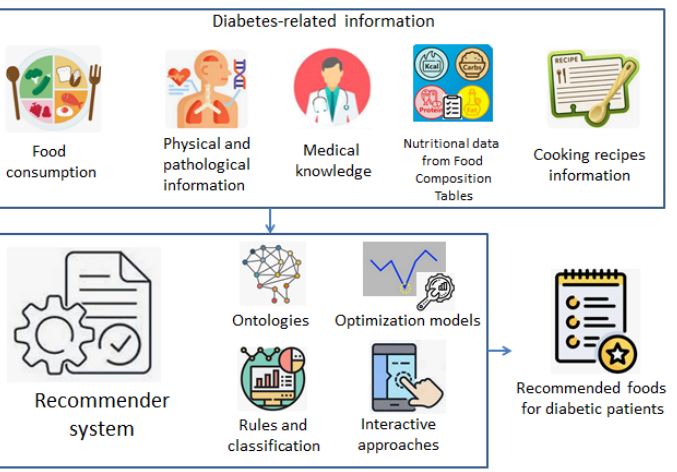
Figure 5. Overview of the data sources and recommendation methods identified at the